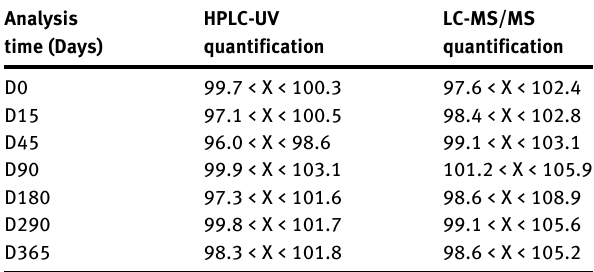
Table  : Data of LC-MS/MS method validation. Parameters assessed